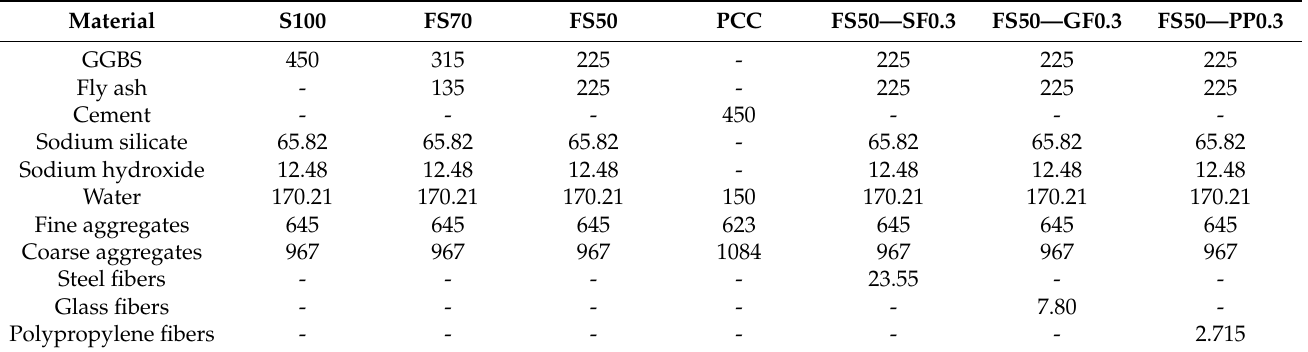
Table 2. Mix compositions (kg/m 3 ) *.